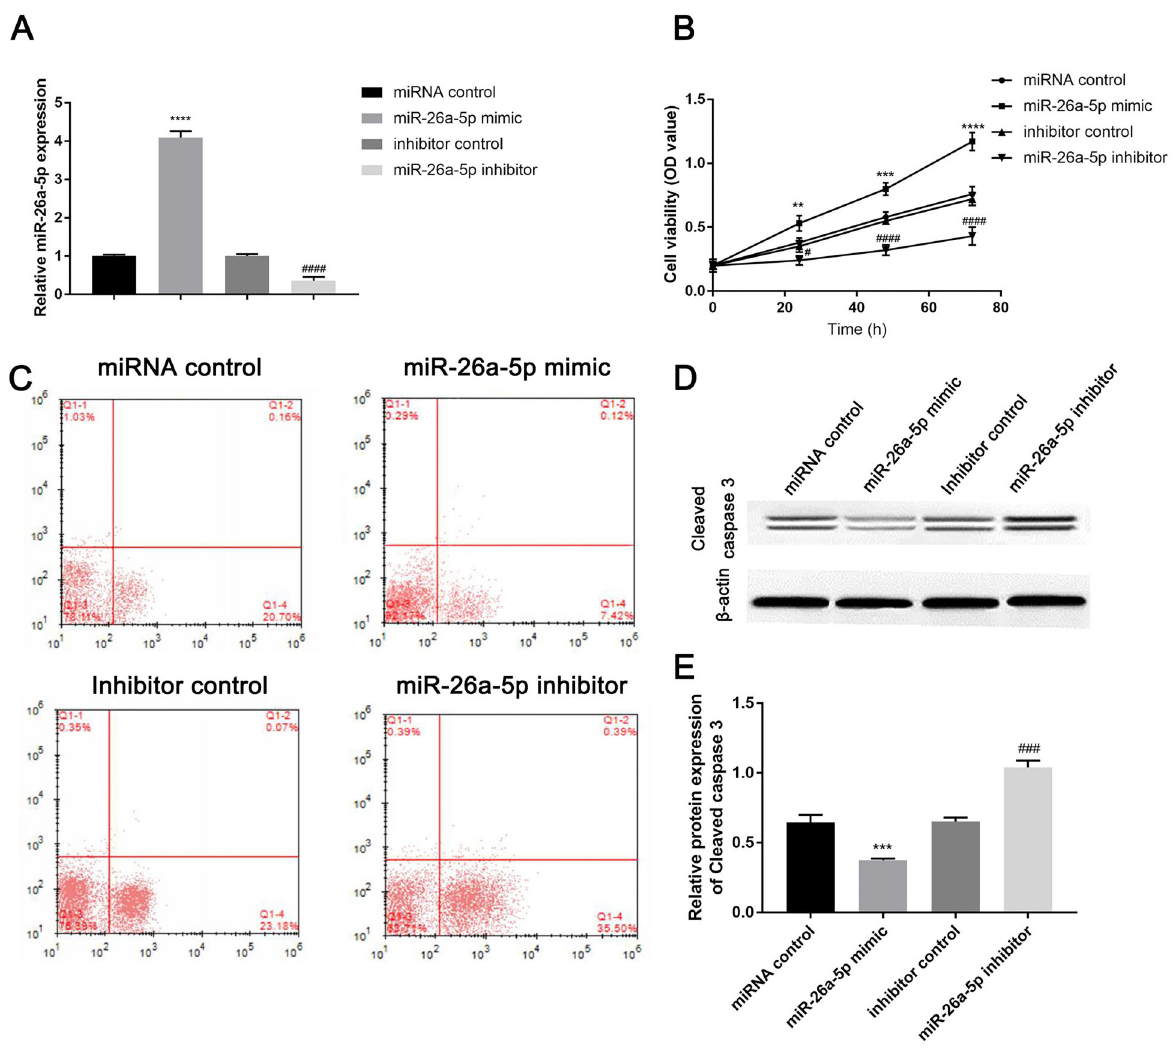
Figure 3. Effect of miR-26a-5p on cell viability and apoptosis. A , After cardiomyocytes were transfected with miR-26a-5p mimic, miRNA control, miR-26a-5p inhibitor, or inhibitor control and treated with hypoxia/reoxygenation, the expression of miR-26a-5p was evaluated by qRT-PCR. The ( B ) viability and ( C ) apoptosis of the cells were detected by MTTand fl ow cytometry, respectively. D , Cleaved caspase 3 expression was assessed by western blot and quanti fi ed by ImageJ software ( E ). Data are reported as means ± SD. **P o 0.01, ***P o 0.001, ****P o 0.0001 vs miRNA control; # P o 0.05, ### P o 0.001, #### P o 0.0001 vs inhibitor control